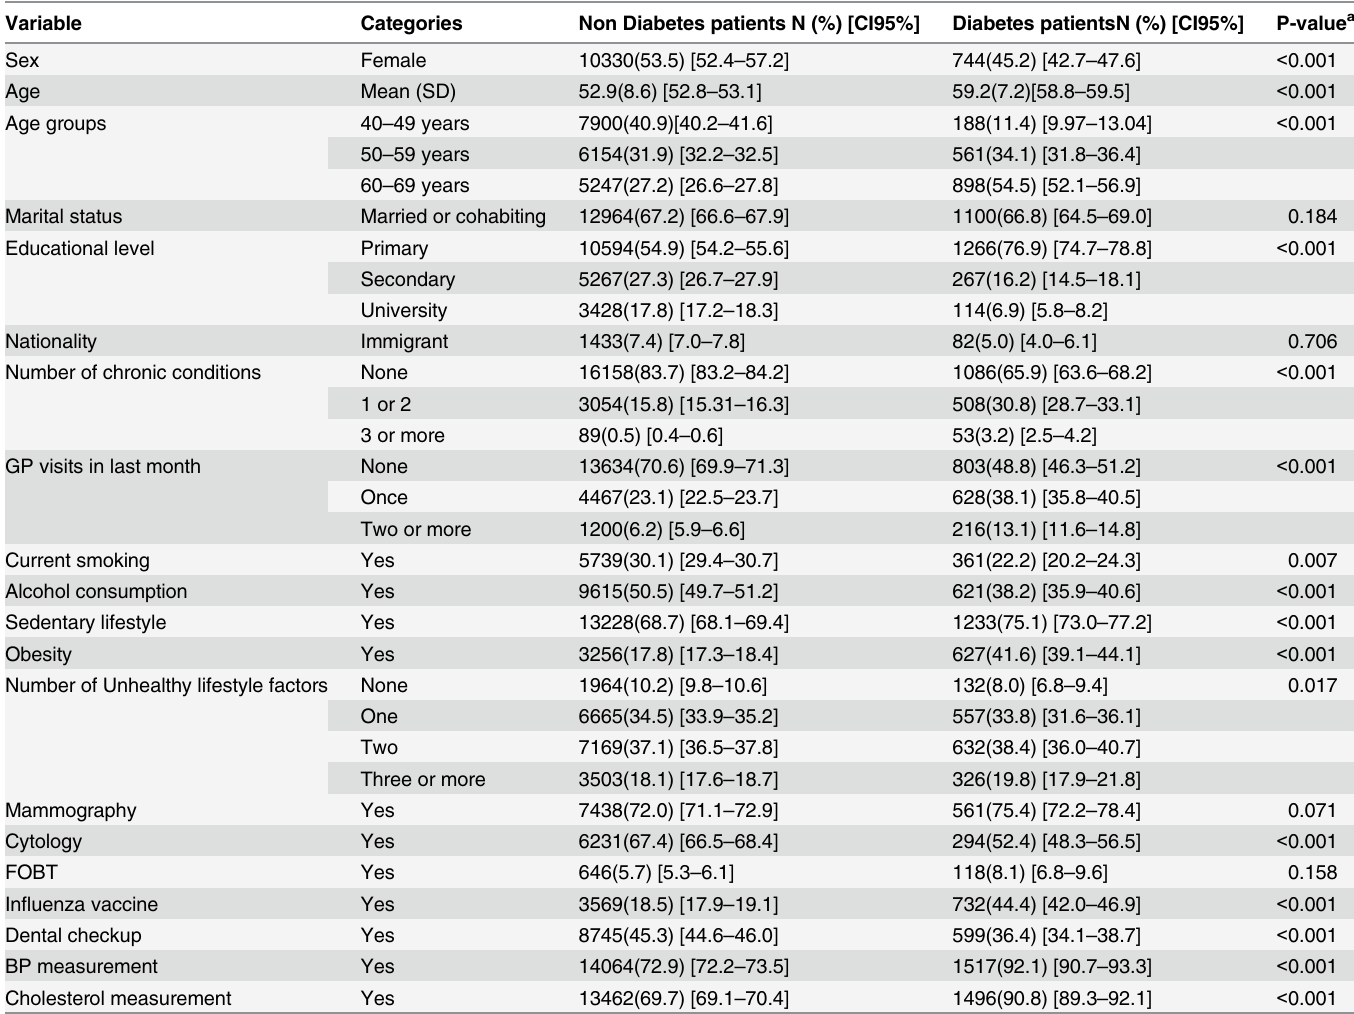
Table 1. Distribution of the study population by diabetes status and according to study